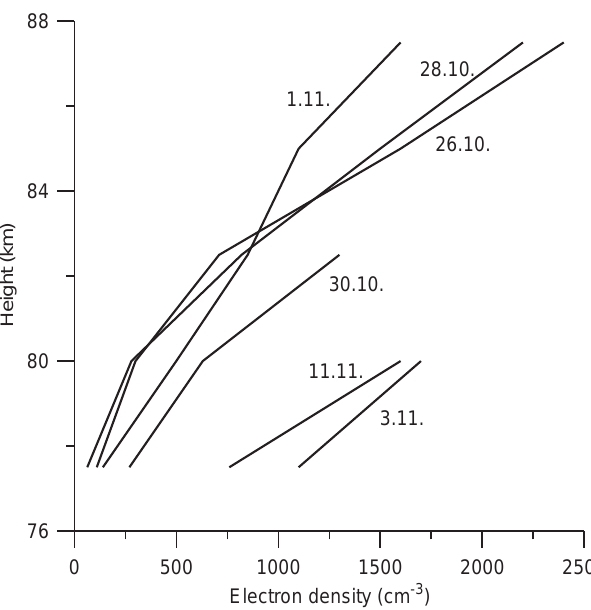
Fig. 6. Development of the electron density profile over Nizhni Novgorod at v = 71 (cid:176) during 26 October–11 November 1994